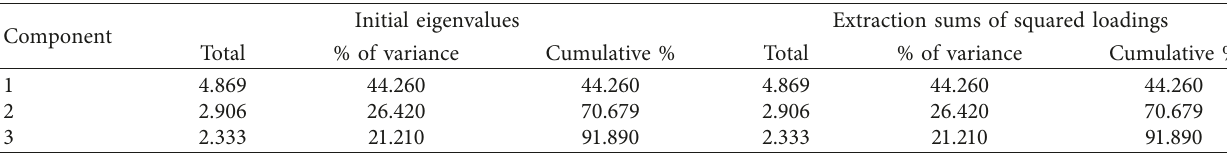
Figure 6: (a) The PCA score scatter plots of samples. (b) The PCA scatter 3D plot of samples. (c) Scree plot. (d) Samples in planar distribution of three Table 7: Characteristic value and variance contribution rate.